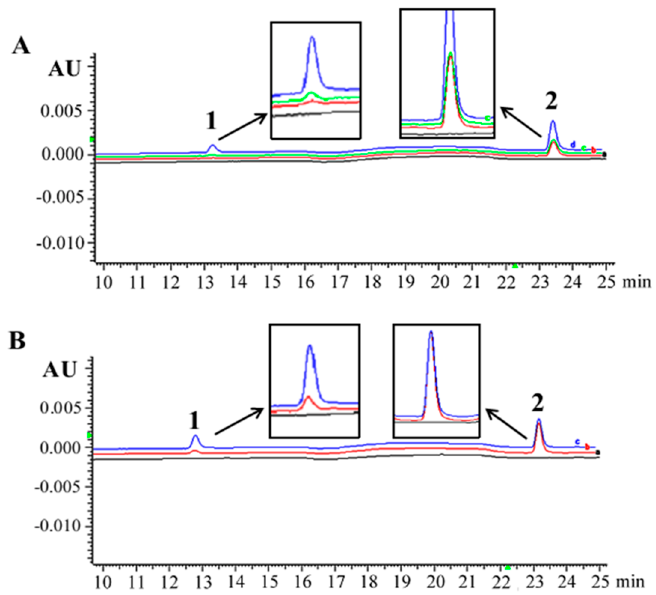
Figure 2. Representative HPLC/DAD analysis of resveratrol in rat thyroid tissue samples and THJ-16T thyroid cancer cells. ( A ) HPLC/DAD chromatograms of normal rat thyroid tissue (black line), thyroid tissue obtained from the rat 30 min after 20 mg/kg resveratrol injection through IG (red line) and IP (green line), normal rat thyroid tissue spiked with 1.0 µ M resveratrol and internal standard/IS (blue line); ( B ) HPLC/DAD chromatogram of control cell lysates (black line), cells treated with 100 µ M resveratrol for 60 min (red line), and control cell lysates spiked with 1.6 µ M resveratrol and internal standard/IS (blue line). Peaks: 1. trans-resveratrol; 2. 1,8-dihydroxyanthraquinone (IS).